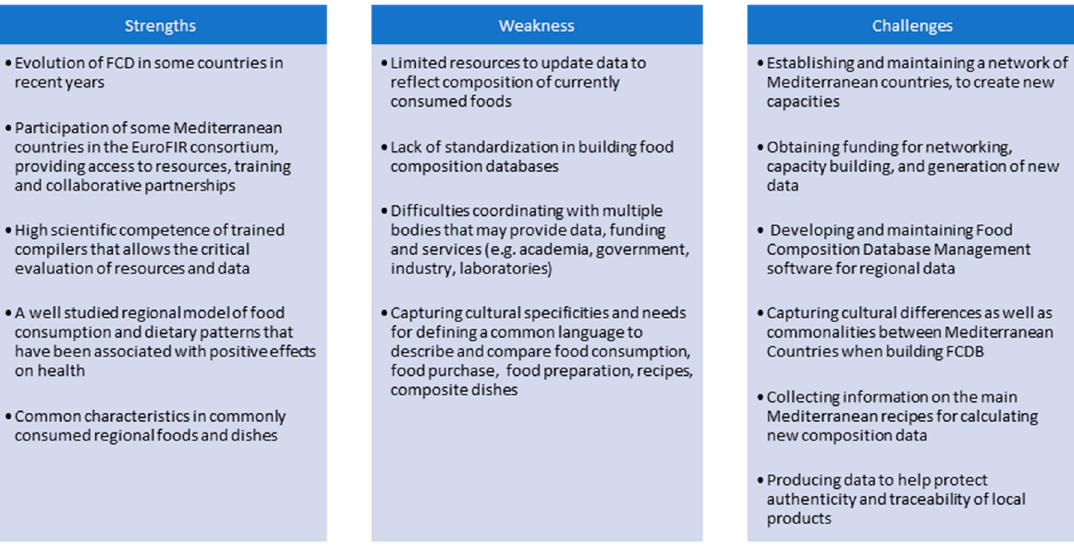
Figure 1. Strengths, weaknesses and challenges of food composition databases (FCDBs) in countries in the Mediterranean region.